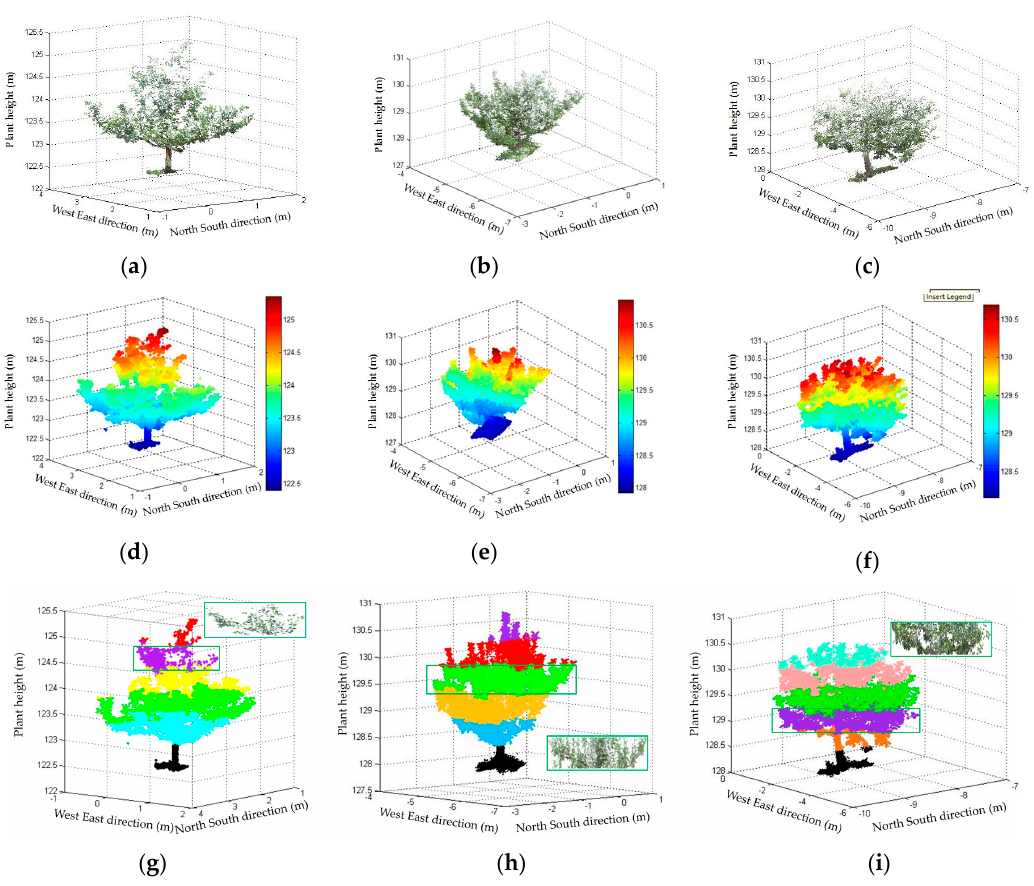
Figure 8. Color extraction based on 3D canopy division. ( a ) The first 3D tree; ( b ) The second 3D tree; ( c ) The third 3D tree; ( d ) Distance of the first 3D tree; ( e ) Distance of the second 3D tree; ( f ) Distance of the third 3D tree;(g) Color extraction of the first tree; (h) Color extraction of the second tree; (i) Color extraction of the third tree.